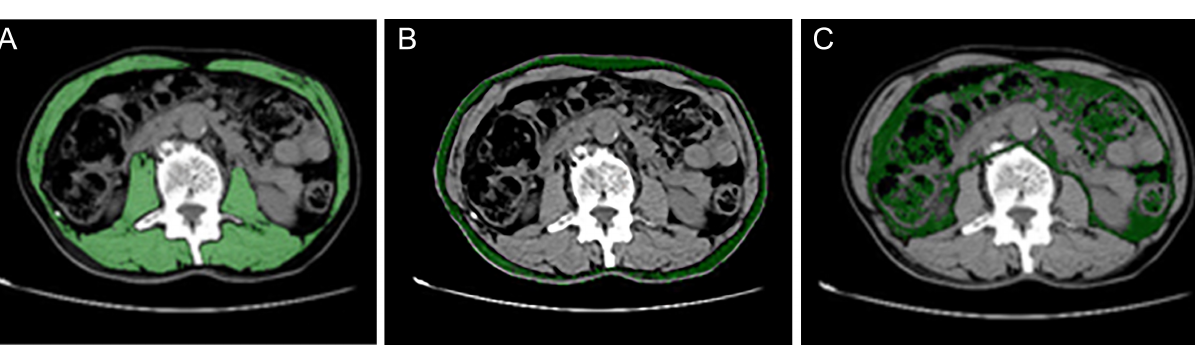
group (11-12 score). Crohn’s disease patients were divided into these subgroups according to best CDAI score related with disease activity. 11 : mild group (150-220 score), moderate group (221-450 score), and severe group ( > 450 score). The skeletal muscle area (SMA), subcutaneous fat area (SFA), and visceral fat area (VFA) were recorded through abdominal CT as shown in Figure 1. Skeletal muscle index (SMI), defined as SMA at the level of the third lumbar vertebra on CT divided by the square of the height, was used to diagnose low mus- cle mass. Male IBD patients with SMI ≤ 45.4 cm 2 /m 2 and female IBD patients with SMI ≤ 34.3 cm 2 /m 2 were con- sidered to have low muscle mass. 12 Meanwhile, the IBD questionnaire (IBDQ) 13 was done among these patients to understand their attitudes to the influence caused by IBD in their life.